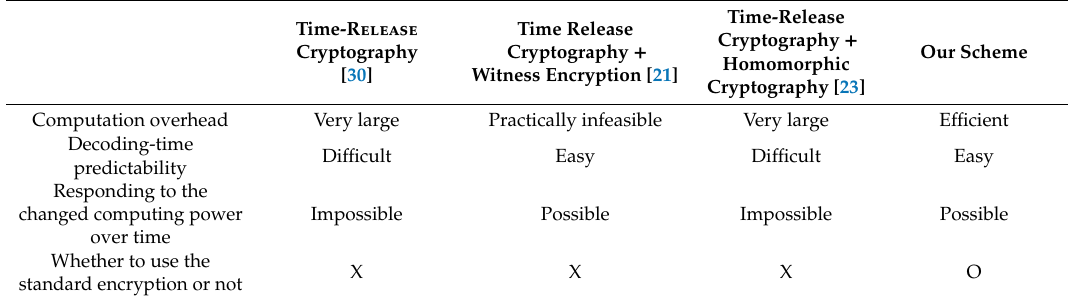
Table 5. Comparison of the previous time-release cryptography and our time-release